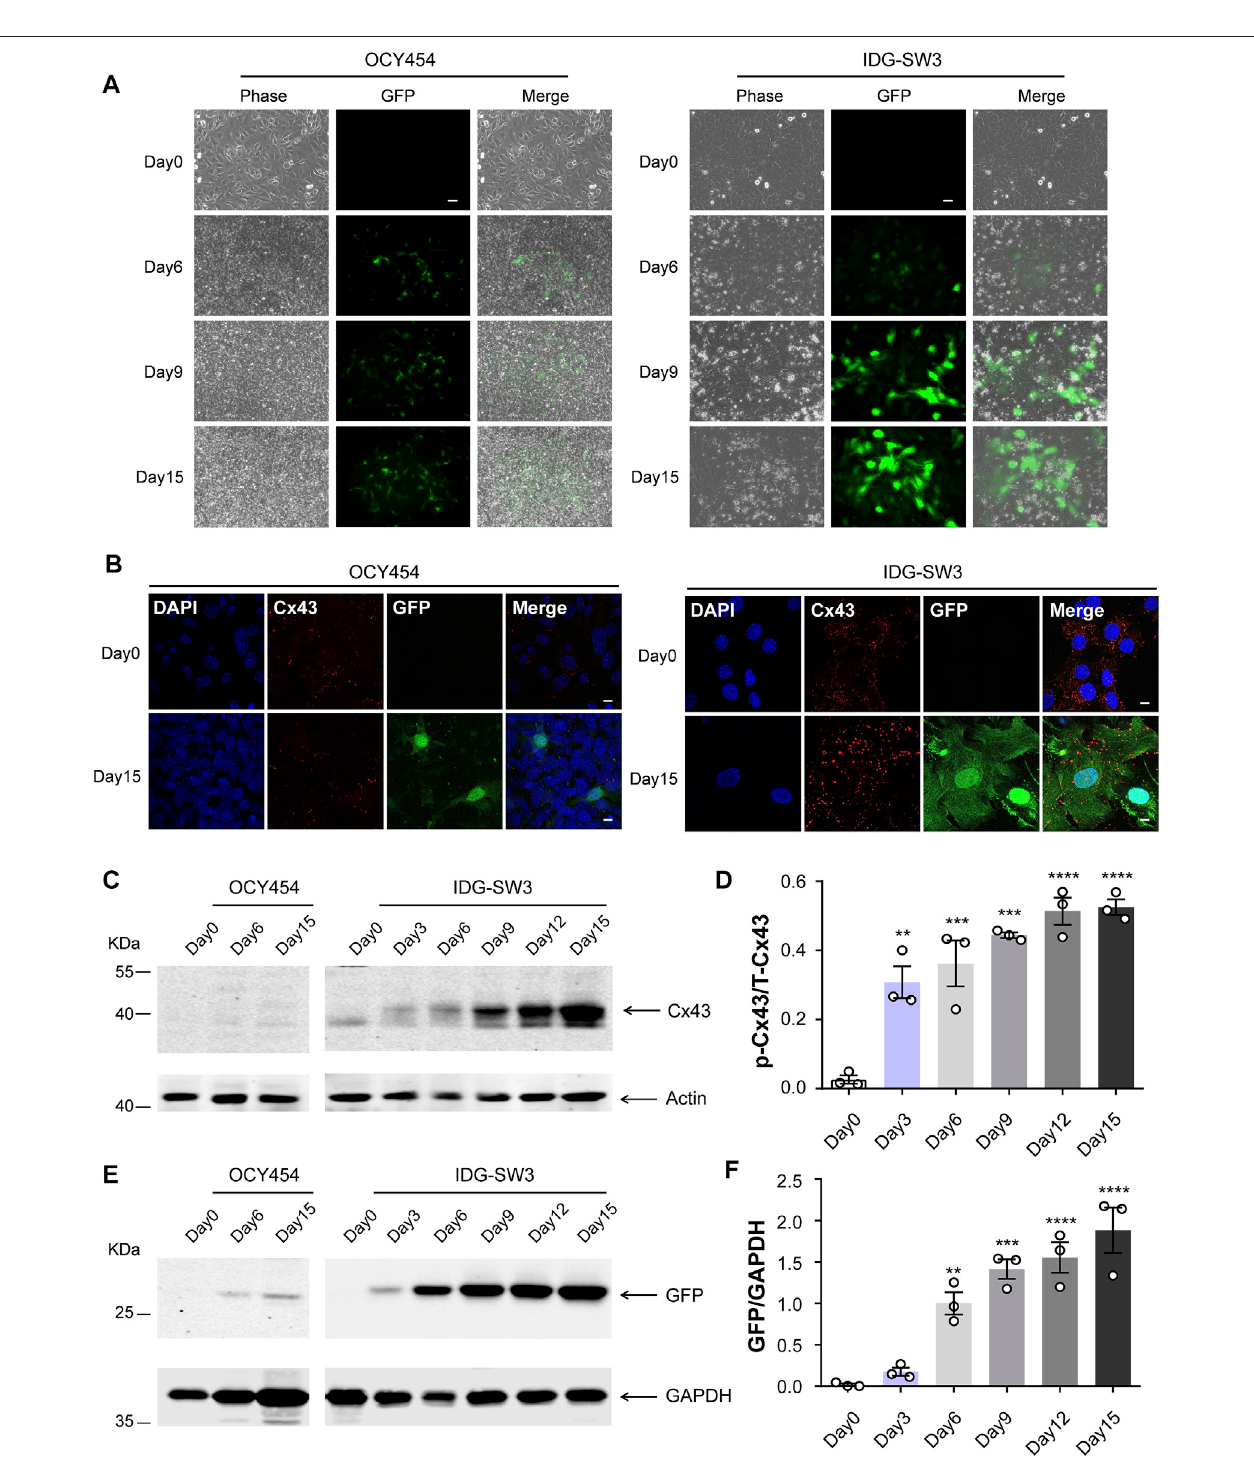
FIGURE 1 | Cx43 expression is increased during osteogenic differentiation in DMP1-GFP – expressing IDG-SW3 and OCY454 cells (A) Representative images of DMP1-GFP expression in OCY454 (left panels) and IDG-SW3 cells (right panels) under fl uorescent and phase-contrast microscopy during the time course from immortalizing(Day0)toosteogenicdifferentiation (Day15). Scalebar,50 μ m. (B) Immuno fl uorescencestainingofCx43 inOCY454(leftpanels) andIDG-SW3cells(right panels) under immortalizing (Day 0) and osteogenic differentiation (Day 15) conditions. Nuclei were stained with DAPI (blue). Scale bar, 10 μ m. (C) Membrane extracts were prepared from OCY454 and IDG-SW3 cells and subjected to immunoblotting using Cx43 (CT) or β -actin antibodies. (D) Densitometry measurement ratio of phosphorylated Cx43 (p-Cx43) to total Cx43 (T-Cx43). (E) Soluble protein extract was isolated from OCY454 and IDG-SW3 cells and subjected to immunoblotting using GFP or GAPDH antibodies. (F) Densitometry measurement ratios of GFP to GAPDH. Data shown are mean ± SEM. **, p < 0.01, ***, p < 0.001, ****, p < 0.0001.